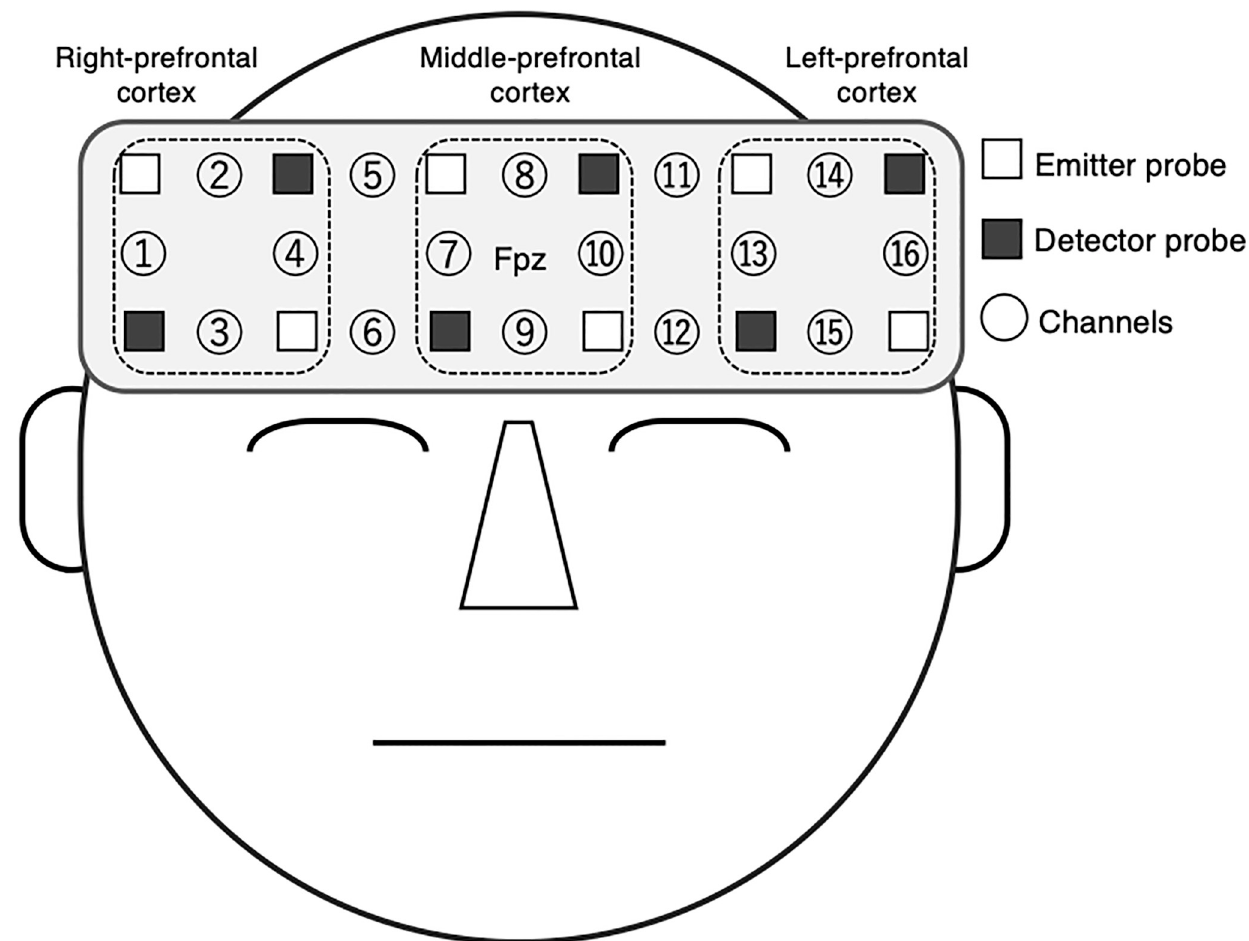
Fig 2. The layout for emitter and detector probes in the headband module of the NIRS device. The center of the probe matrix was placed on the Fpz (International 10–20 System).